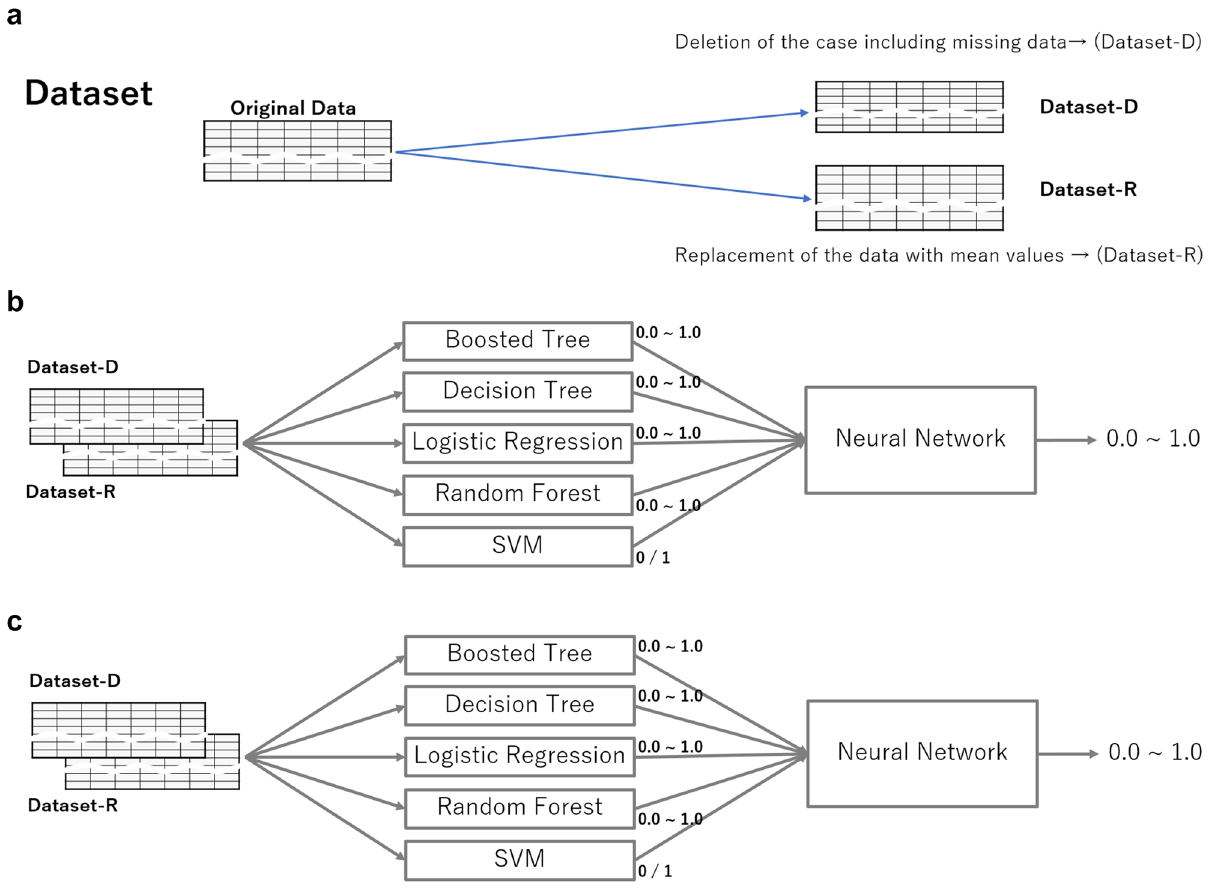
Figure 1. An illustration of the analysis pipeline.